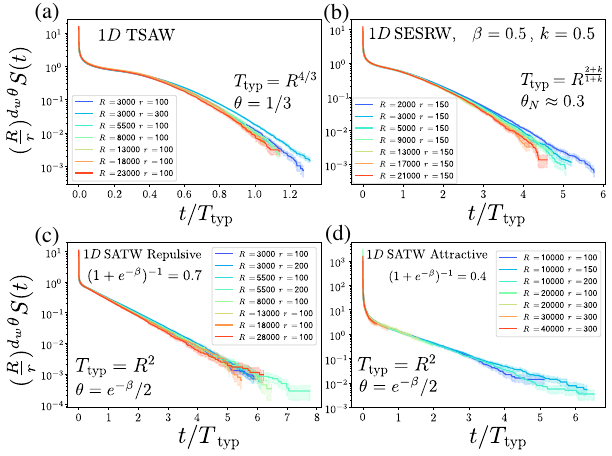
FIG. 5. Asymptotic FPT distribution of compact self-interact- ing random walks in confined domains for fresh initial con- ditions. Here, S ð t Þ is the survival probability of the random walker, whose scaling with geometrical parameters is deduced from Eq. (21). The collapse of numerical simulations after rescaling for different values of geometric parameters captures the dependence of the FPT distribution on the geometric parameters r , R (the target is a unique site of the network). Simulations are performed in 1 d boxes of size R with reflecting 3 = 2 (independent boundary conditions. (a) 1 D TSAW with d w ¼ of β ). (b) 1 d SESRW with β ¼ 0 . 5 and k ¼ 0 . 5 . (c) 1 d